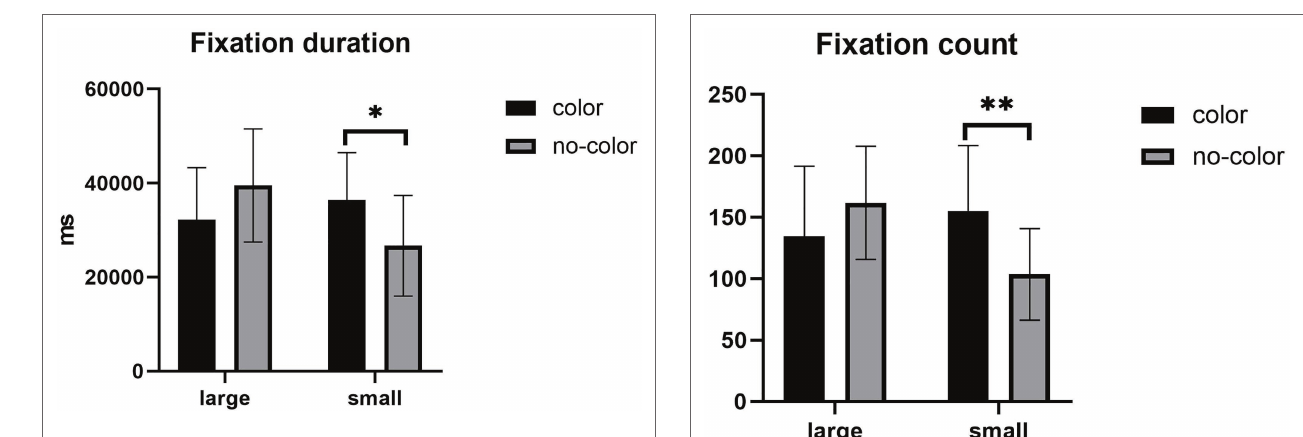
FIGURE 3 | Mean of fixation duration. Error bars represent standard errors of the means ( * p <